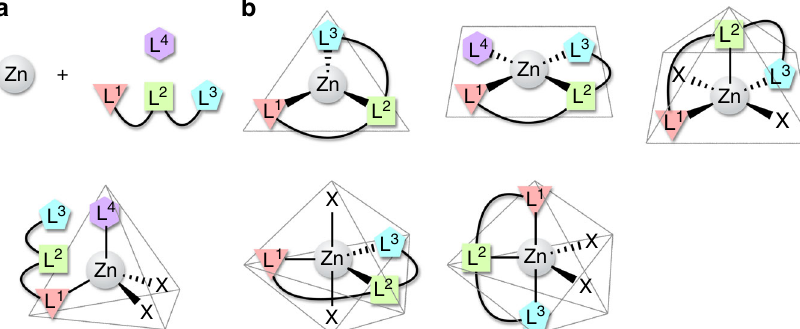
Fig. 2 Possible stereoinversion pathways of a tetrahedral zinc centre coordinated by an achiral, unsymmetric tridentate ligand. a Stereoinversion pathways of stereoinversion by complete or partial dissociation of the tridentate ligand. b Some stereoinversion pathways without dissociating the tridentate ligand. X arbitrary